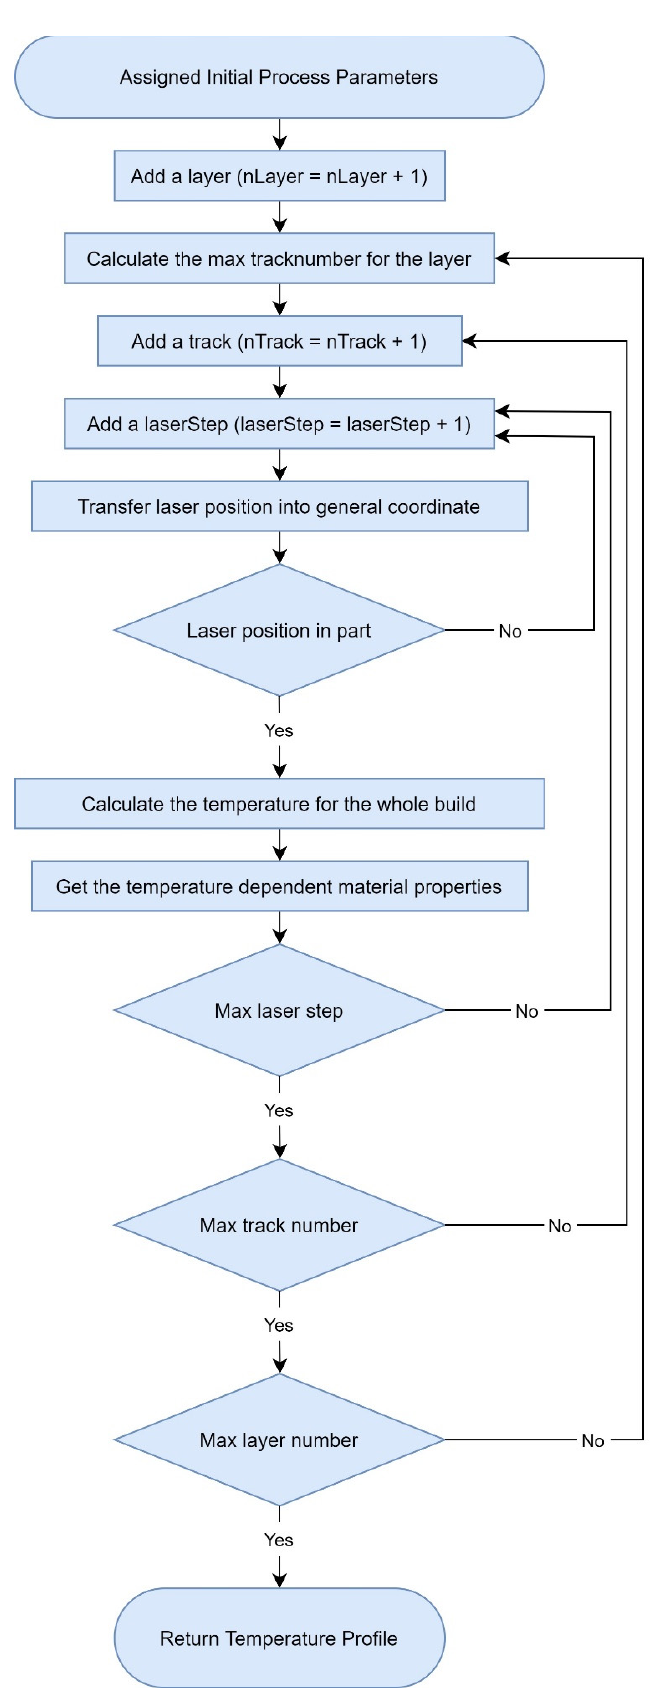
Figure 3. Flow chart for the calculation process.